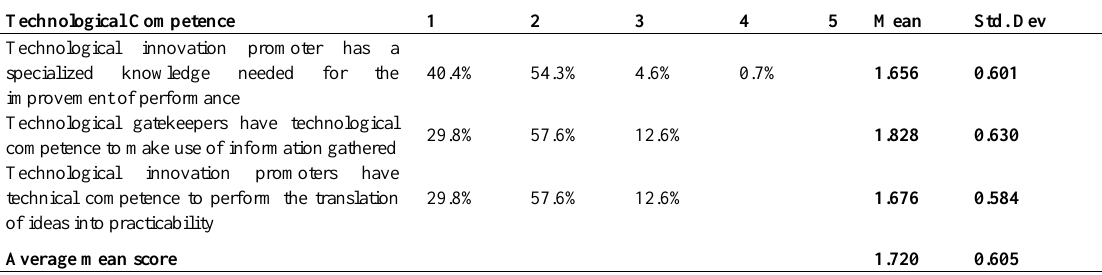
Table 5: Technological Competence Descriptive statistics